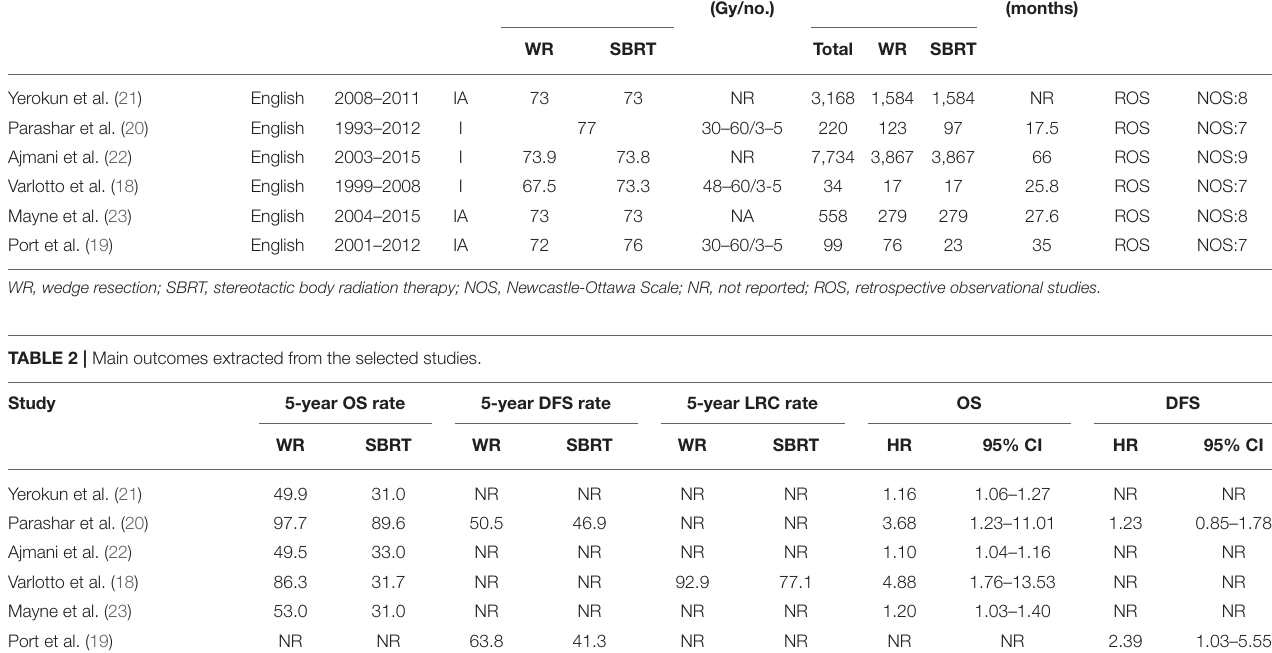
Study Quality follow-up type assessment (months)